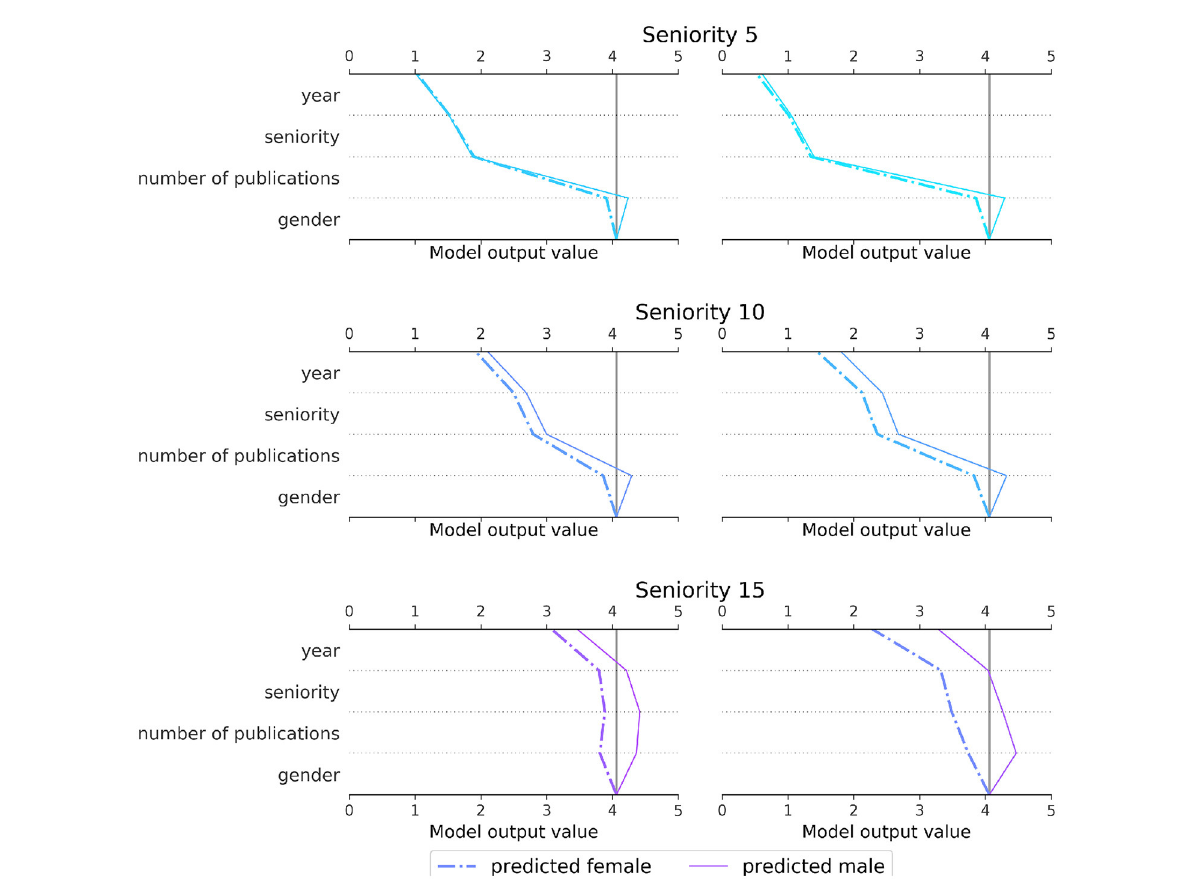
FIGURE11 SHAP decision plot of a Gradient Boosting classifier predicting the number of single authorships for twelve different personas. We display the local relevance of the four main features “year,” “seniority,” “number of publications,” and “gender.” The curves representing the SHAP values are relative to the model’s expected value which is approximately four in this case. The SHAP values for each feature are successively added to the expected value of the model (viewed from the bottom up), showing how each feature contributes to the overall prediction. The rows represent different seniority levels (5, 10, and 15), the columns correspond to the subfield clusters “PDE/Numerical/Physics” (left) and “Number theory/Algebraic geometry” (right) , while the line types differentiate between the persona’s gender. We assumed the continent to be North America, the publication year to be 2010 and the dominating journal rank to be